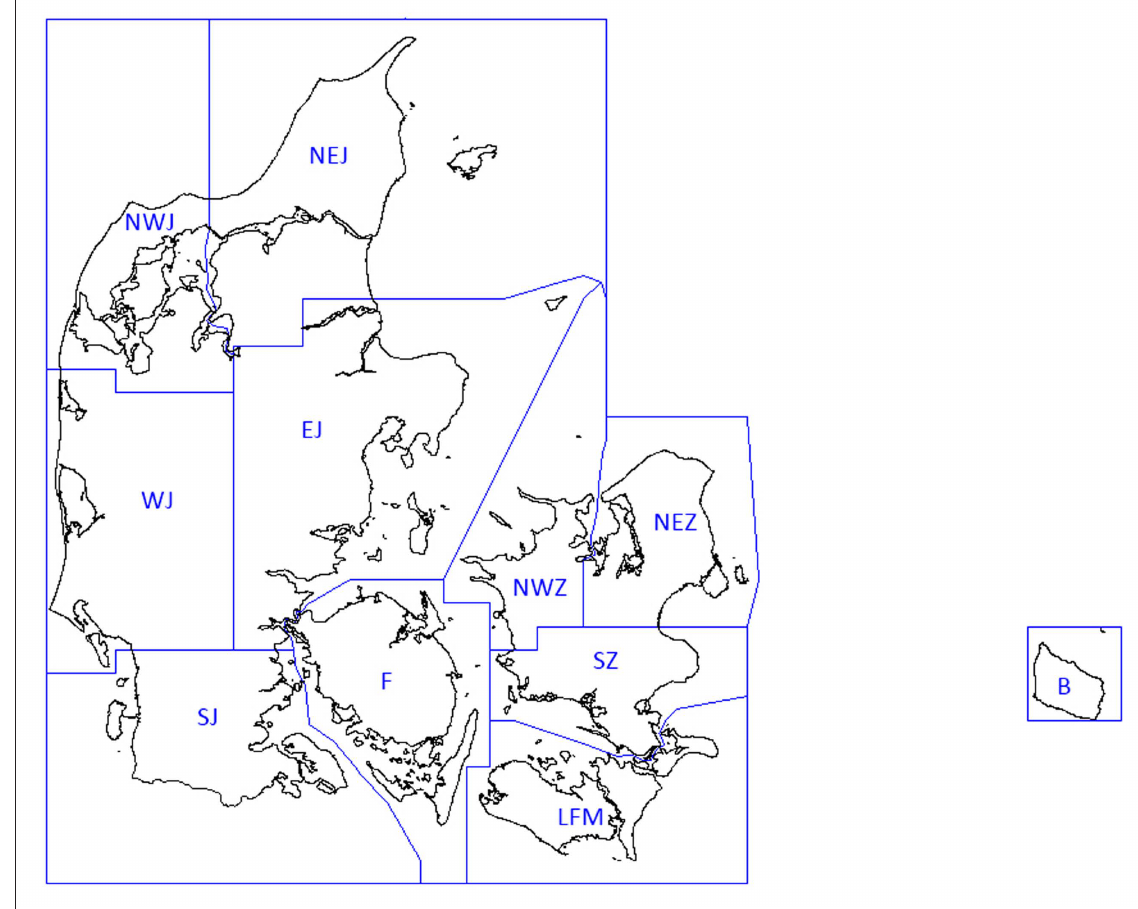
Fig. 92. Danish districts. See the text for abbreviations and names (under Material and methods –